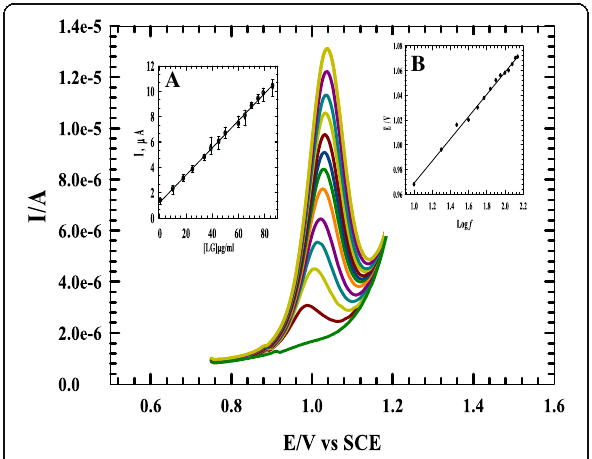
Fig. 6 SWV of the successive additions of LG in B – R buffer and 10 mV/s. Inset a : The calibration curve of LG at CPE/Fe 2 O 3 NPs. Inset b : The dependence of E p with log f for LG using Eq.